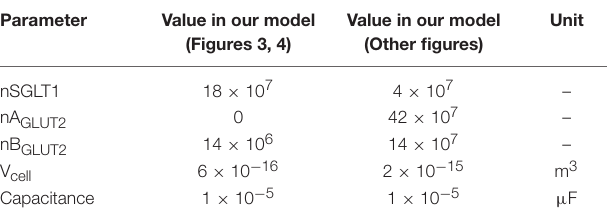
TABLE 3 | Parameter values used in the